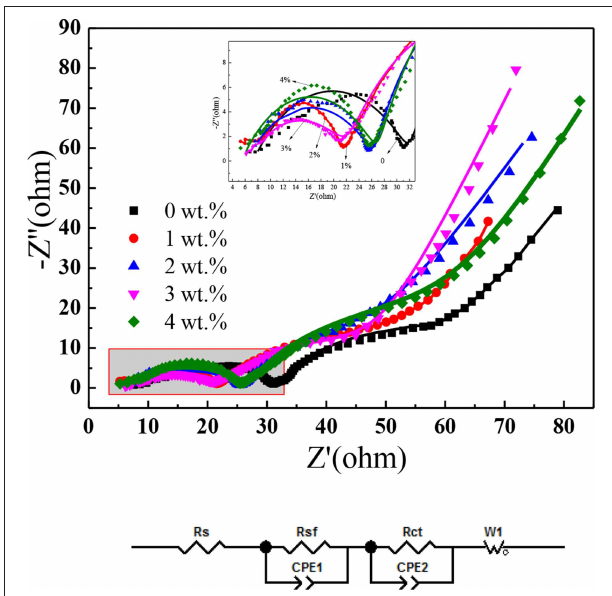
FIGURE 7 | Nyquist plots and equivalent circuit for x wt% SnO 2 -modified NCM ( x = 0, 1, 2, 3, 4) positive electrode materials.